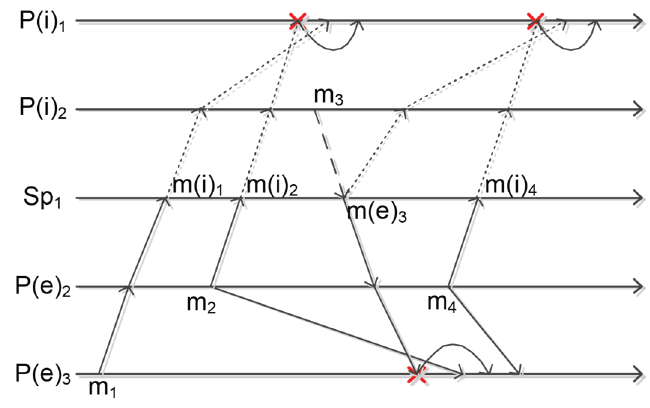
Figure 3. Scenario example.